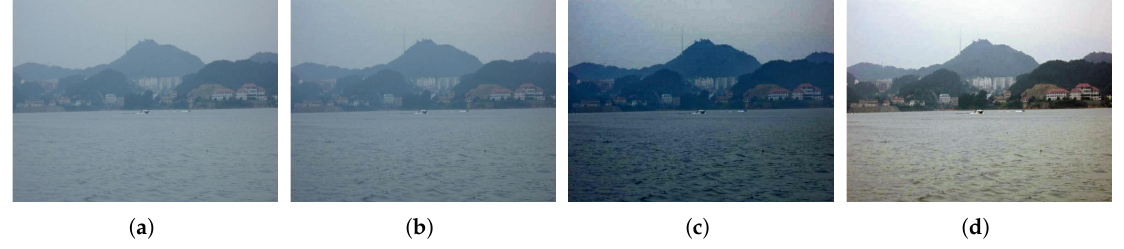
Figure 1. Overwater image dehazing example. The proposed method generates more clear images compared to state-of-the-art methods. ( a ) Hazy input, ( b ) Cai [13], ( c ) Yang [4], ( d )